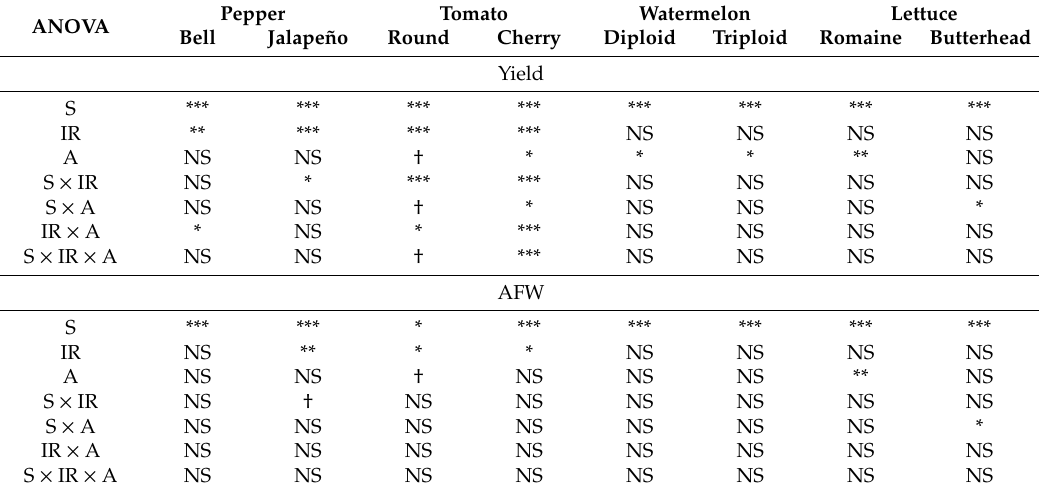
Table 3. ANOVA of total yield, average fruit weight (AFW) as influenced by amendments (A) and irrigation (IR) treatments during the two growing seasons (S). Pepper Tomato Watermelon Lettuce ANOVA